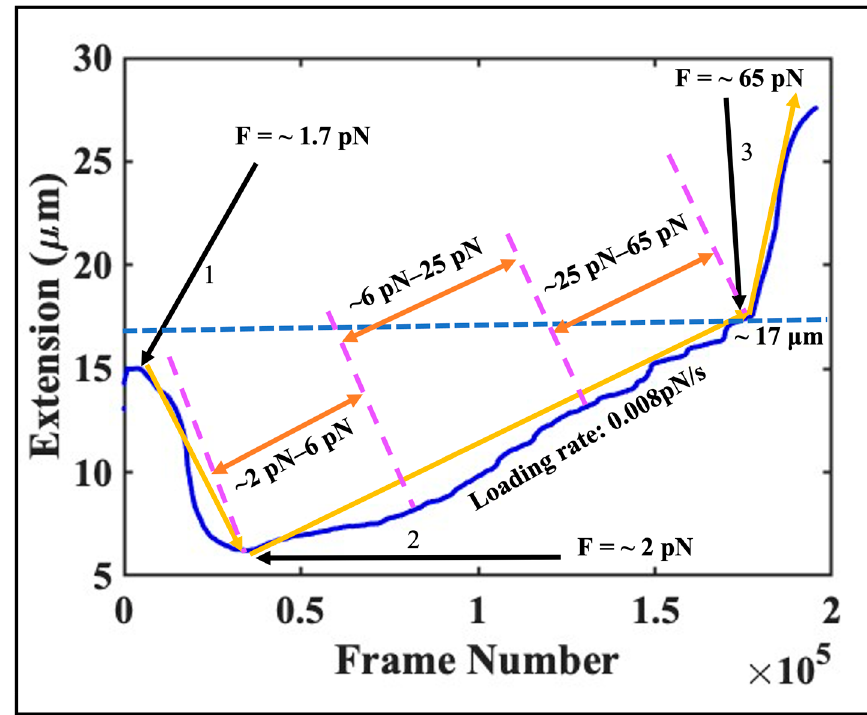
Figure 1. A plot of extension vs. time (number of frames) from a typical DNA–protein (hyperacetylated histones) interaction experiment. The tether extension of ~15 μ m , corresponding to a force of ~1.7 pN , at which we injected hyperacetylated histones into the sample chamber using the bu ff er exchange approach is shown by arrow 1. The region between arrows 1 and 2 indicates the DNA’s compaction from ~15 μ m to ~6.5 μ m due to nucleosome array formation. The DNA extension increases from ~6.5 μ m to ~17 μ m as the force rises from arrows 2 to 3. The data above arrow 3 correspond to the DNA’s overstretching transition, which occurs around ~65 pN as expected.